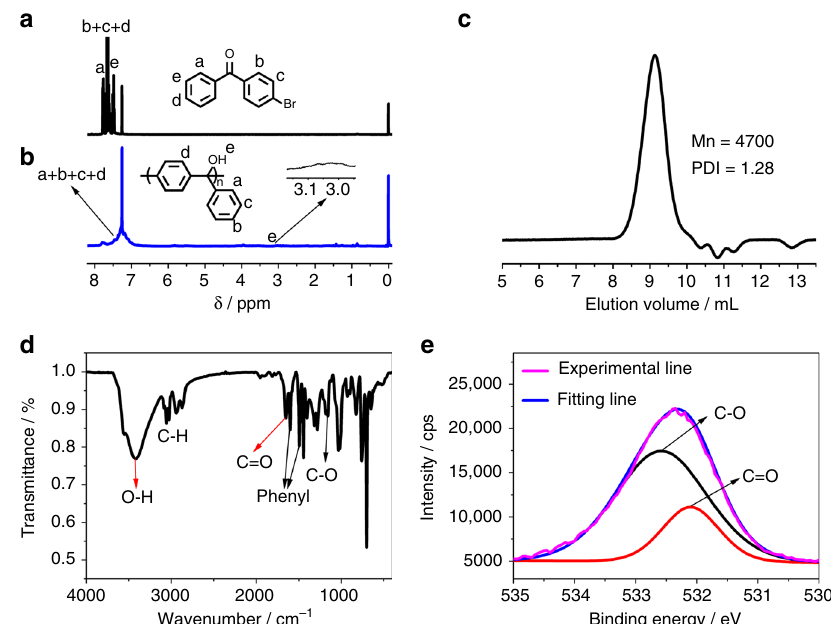
Fig. 2 Characterizations of PTPM-1. 1 H NMR spectra of 4-bromobenzophenone ( a ) and PTPM-1 ( b ) in CDCl 3 , GPC curve of PTPM-1 ( c ) in THF, FT-IR spectrum of PTPM-1 ( d ) and XPS O1s spectra of PTPM-1 ( e )